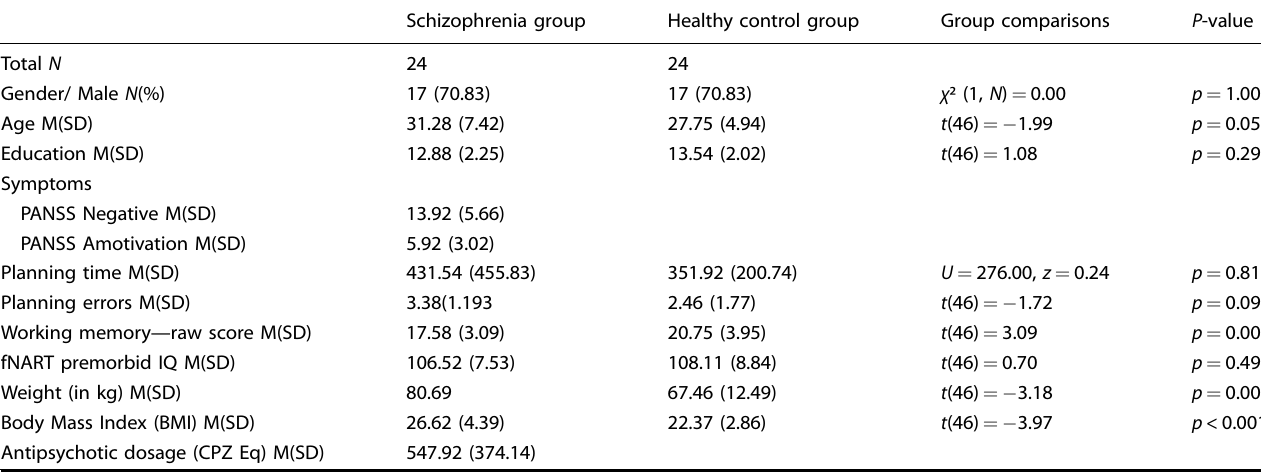
Table 1. Sociodemographic and clinical